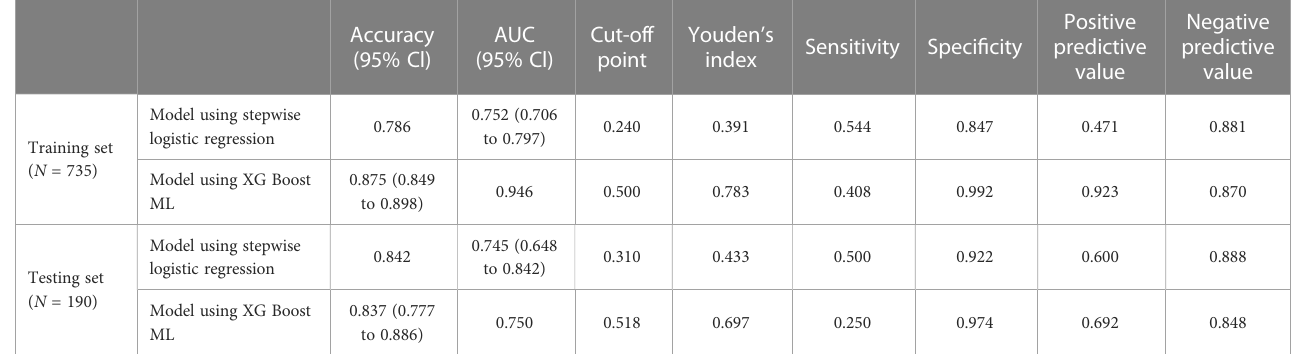
FIGURE 5 The calibration plots of the testing set by LR. LR, logistic